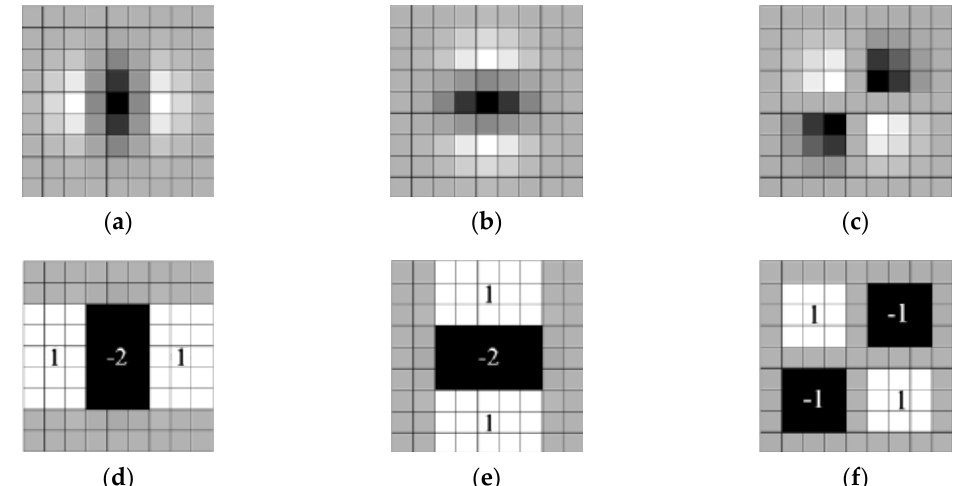
Figure 4. Gaussian filter template and its substituted template: ( a ) L xx ; ( b ) L yy ; ( c ) L xy ; ( d ) D xx ; ( e ) D yy ; ( f ) D xy .